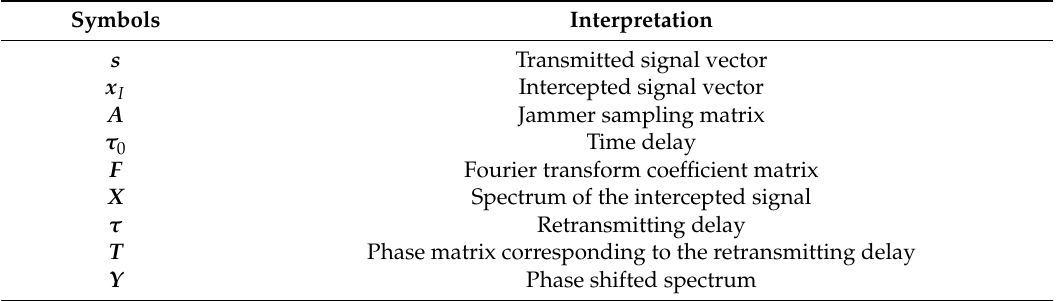
Table 1. Main notations used in the